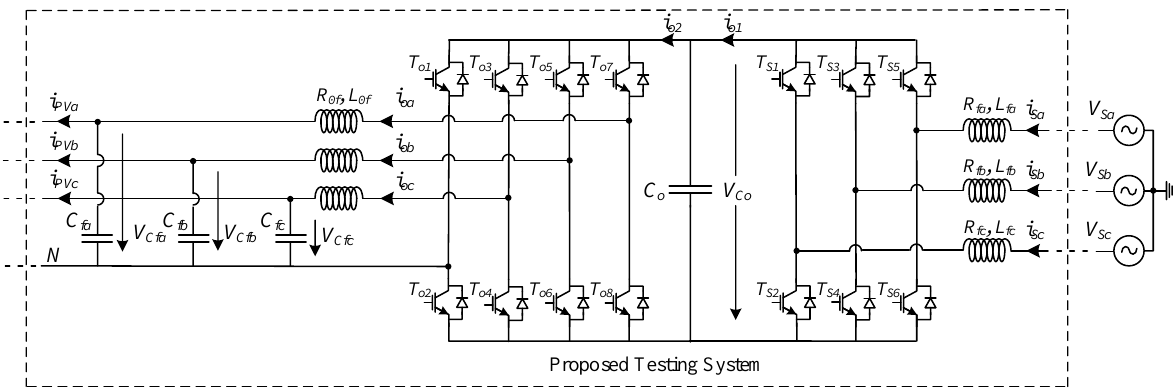
Figure 2. Power circuit configuration of the proposed DC-DC converter for transformerless PV applications.